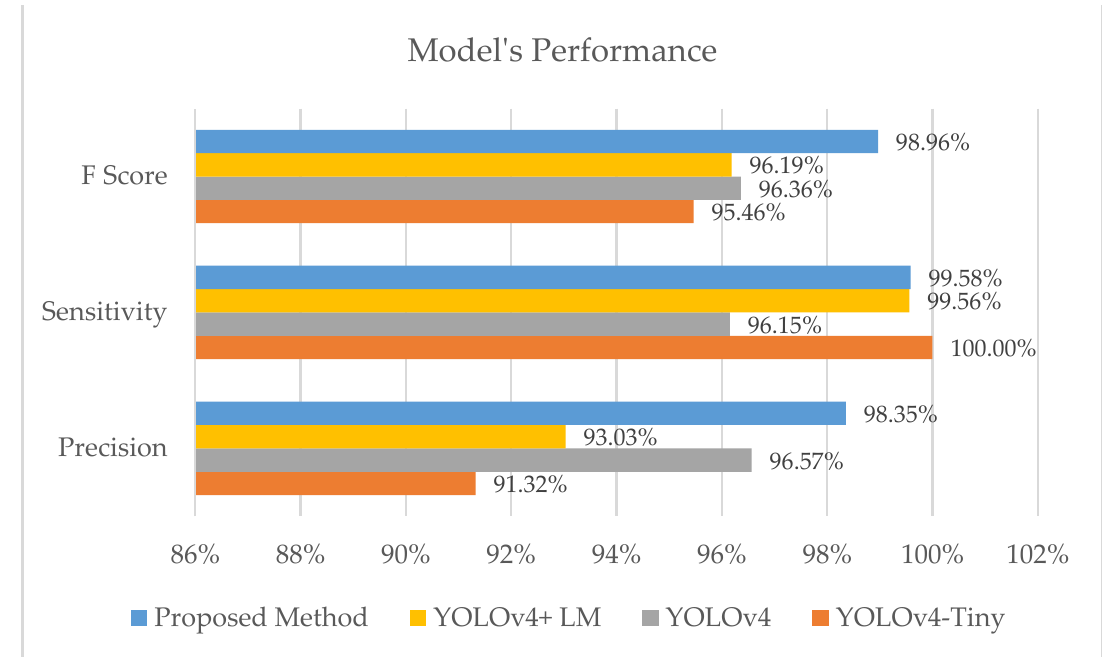
Figure 8. Experimental results (accuracy).